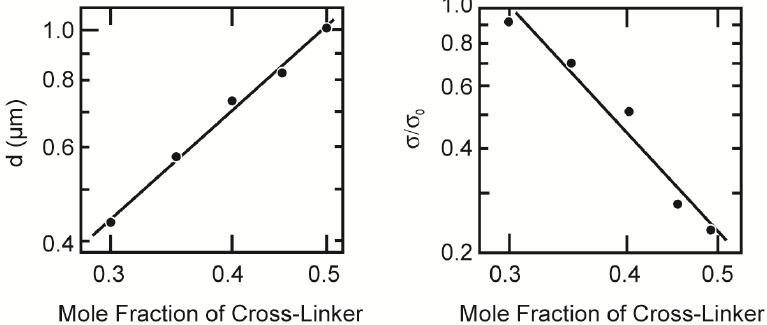
Figure 10. The structural parameters of the opaque gel. The diameter of the colloid particle is plotted as a function of the mole fraction of the cross-linker ( left ); The right figure represents the cross-linker concentration dependence of the relative occupied area by the colloid particle. Both parameters are plotted in the double logarithmic manner. Lines are drawn only to guide the